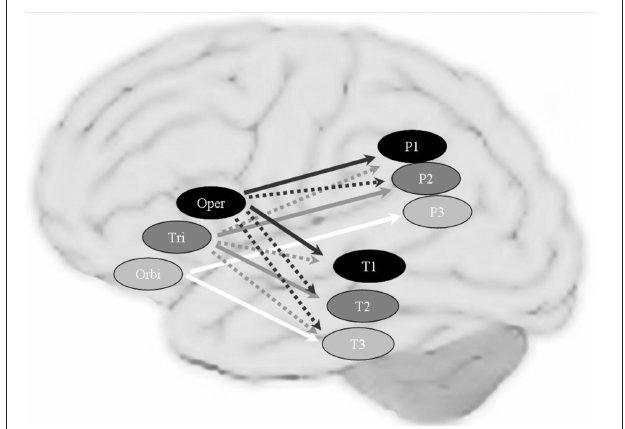
FIGURE 5 | Simplified illustration of the anatomy and connectivity of the left hemisphere language network. Cortical areas are represented as red circles: pars orbitalis (or), pars triangularis (tr) and pars opercularis (op) of the LIFC; angular gyrus (ag), superior and middle temporal gyri (tg), fusiform gyrus (fg) and temporal pole (tp). White matter fibers are shown in gray, arrows emphasize bi-directional connectivity: arcuate fasciculus (AF), extreme capsule (EC), inferior longitudinal fasciculus (ILF) and uncinate fasciculus (UC). Interfaces with sensory-motor systems are shown in green: visual cortex (vc), auditory cortex (ac) and motor cortex (mc).